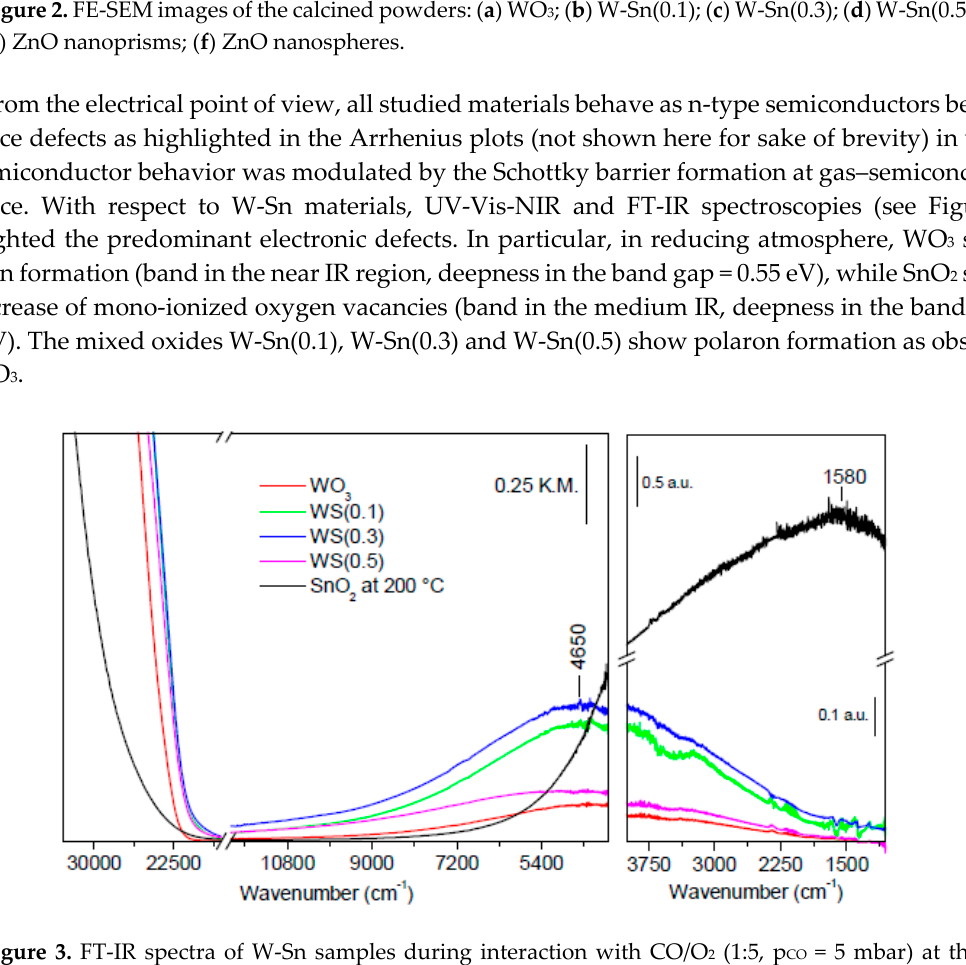
Figure 3. FT-IR spectra of W-Sn samples during interaction with CO/O 2 (1:5, p CO = 5 mbar) at the temperature of the maximum absorption